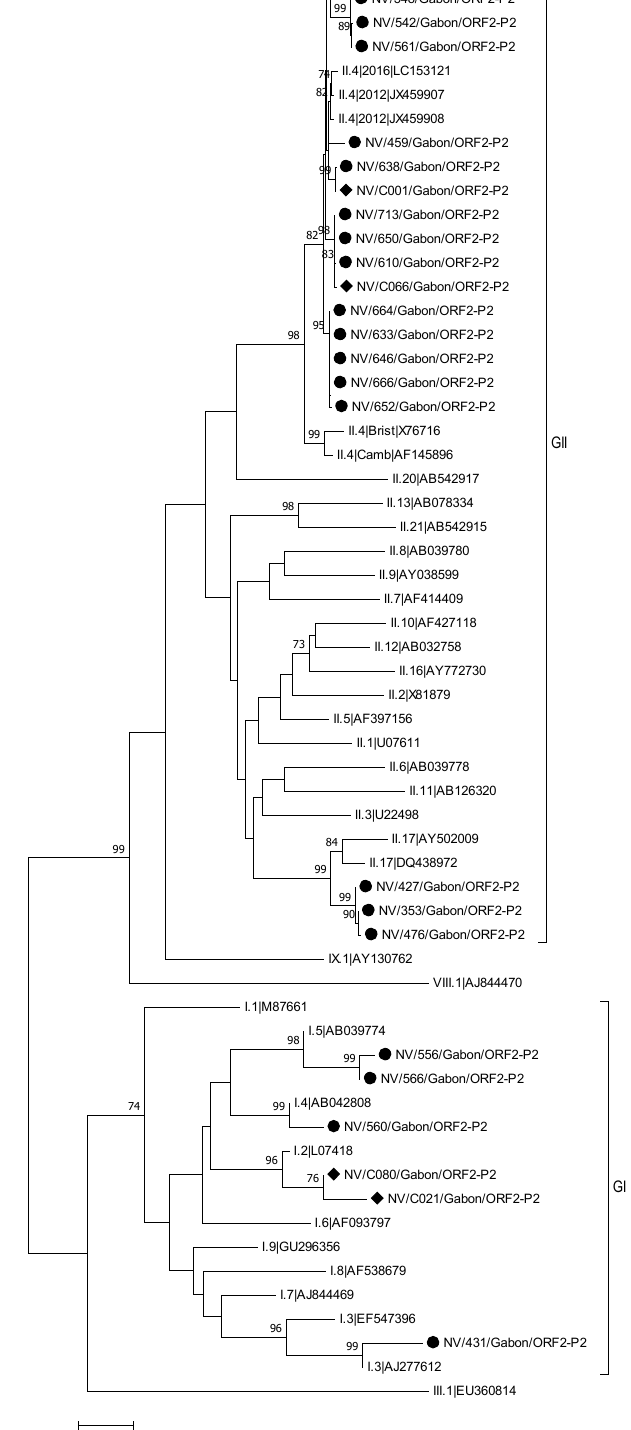
Figure 3. Phylogenetic tree of a 691 bp alignment of P2 region (ORF2) of the GI and GII NoV strains from Gabon and NoV reference sequences (accession nos. are indicated). Samples from symptomatic patients are marked with a dot and samples from asymptomatic patients with a rhombus. The tree was constructed using the neighbor-joining method with the bootstrap test (1000 replicates) and the Kimura 2-parameter method available in MEGA7. Bootstrap values above 70 are shown. The bar indicates the nucleotide substitution per